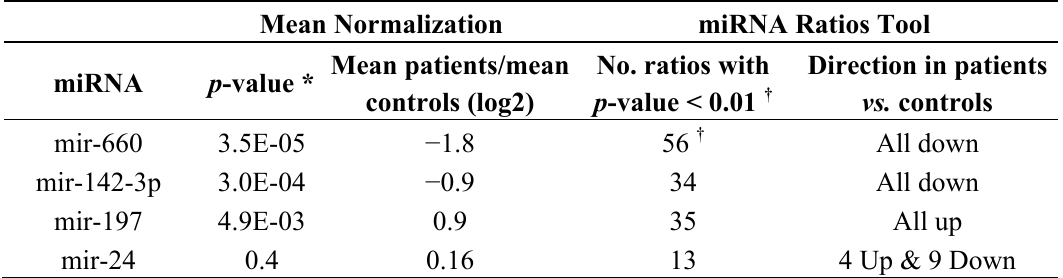
Table 1. Comparison between the results obtained normalizing on the mean expression value or using the miRNA ratios tool. Mean patients/mean No. ratios with miRNA p -value * controls (log2) p -value < 0.01 †